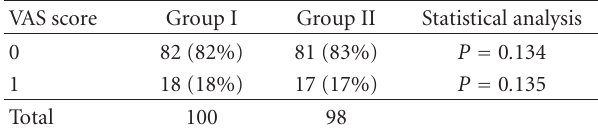
Table 3: Depth Of anesthesia using the VAS.